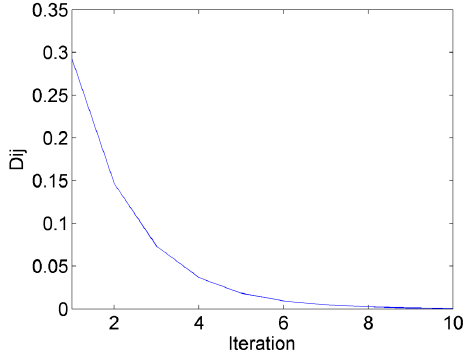
Figure 3. The convergence diagram of the physarum network (PN) algorithm (corn data) in the first round: Iterations vs. D ij ( D ij is the rate of change of the network continuity). When the iteration is 10, all the D ij are smaller than the threshold of stop, and the network